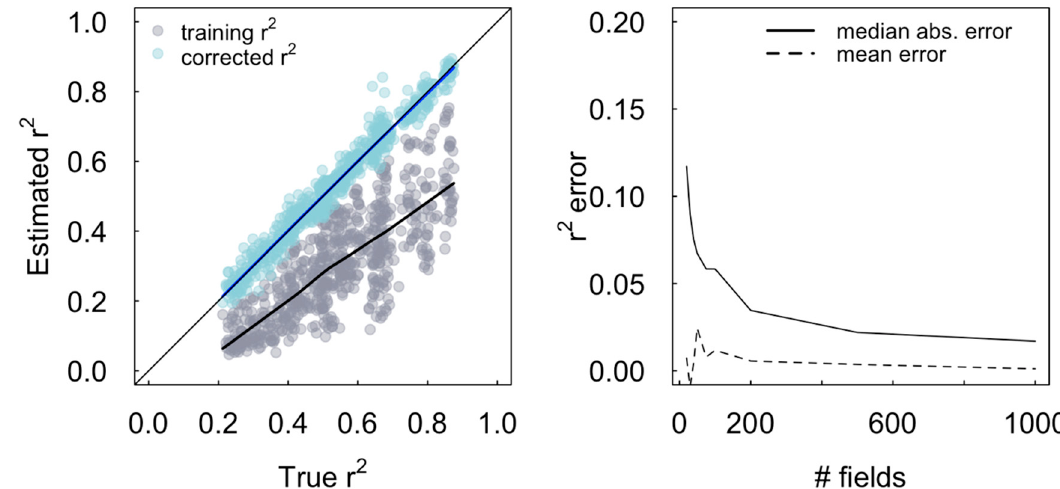
Figure 2. Simulated performance of Equation (14) to correct the measure of satellite performance for noise in ground data. ( left ) Training r 2 (gray points) and corrected r 2 (blue points, using Equation (14)) for a linear regression model that predicts ground-measured yields with satellite-measured yields for 1000 fields, plotted against the “true” r 2 between satellite-measured and true yields. True yields and the noisy ground- and satellite-based measures of yields were simulated from Equations (4)–(8), (11) and (12), with each point representing a single set of simulation parameters, and simulations then repeated for different combinations of parameter values to span a wide range of r 2 . Lines show a locally-weighted polynomial (LOWESS) fit to the points. Parameters ranged from 1 to 3 t/ha for s Y , and 0.5 to 3 t/ha for σ (cid:101) . The value of m was fixed at 5 t/ha, since varying this value does not affect the resulting r 2 . Overall, training r 2 underestimates the true r 2 , whereas Equation (14) results in an unbiased estimate of the true r 2 . ( right ) The difference between the true and corrected r 2 (from Equation (14)) plotted against the number of fields simulated. The mean difference (i.e., bias) remains small when a small number of fields are simulated, but the median absolute error rises sharply when fewer than 100 fields are measured.